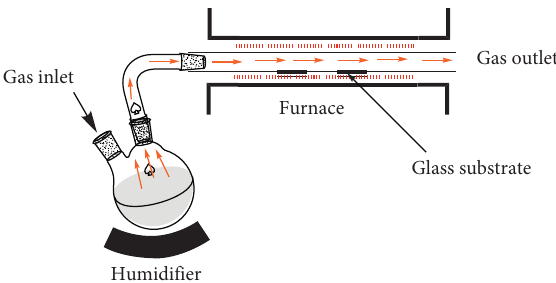
Figure 1: A schematic diagram of the AACVD